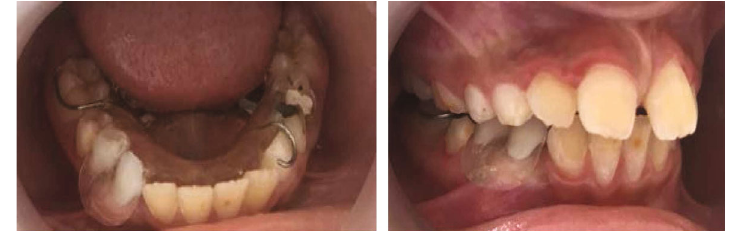
Figure 7: Removable space maintainer acting as an acrylic obturator used to guide the eruption of the premolar.